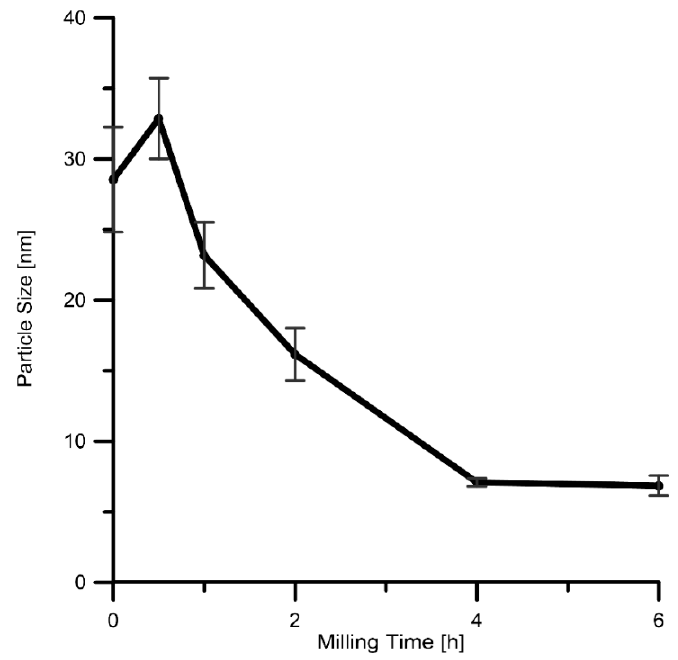
Figure 8. Powder particle size vs. milling time for alloy FeAl20Si20.